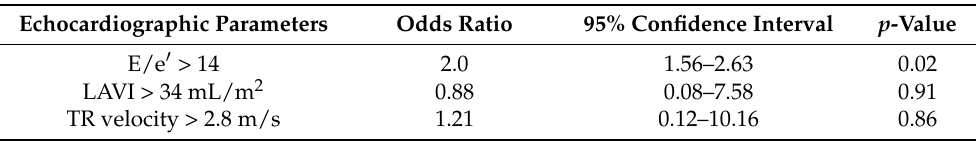
Table 2. Multivariable logistic regression analysis of echocardiographic left ventricular filling pressure parameters associated with iFR/FFR